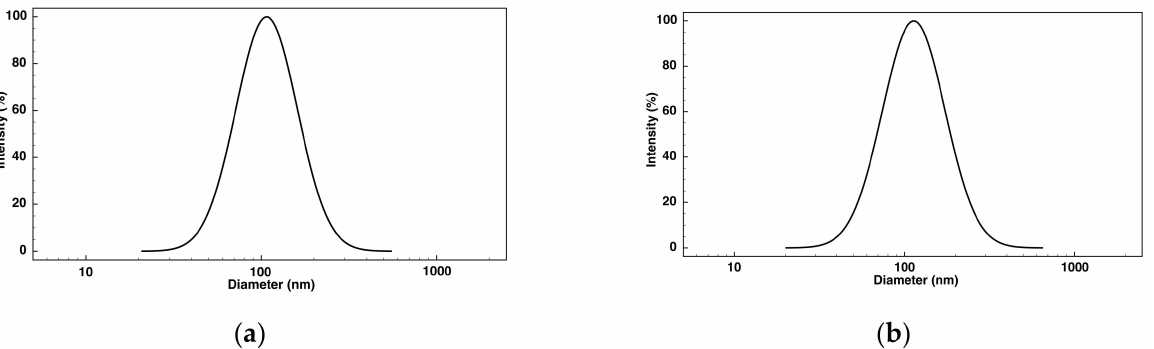
Figure 4. Size distribution curves from DLS measurements of 0.05 mg mL − 1 aqueous spherical nucleic acid dispersions of: ( a ) PLA-SNA (d = 107 nm, PdI 0.176); ( b ) PLA- co -PC-SNA (d = 113 nm, PdI